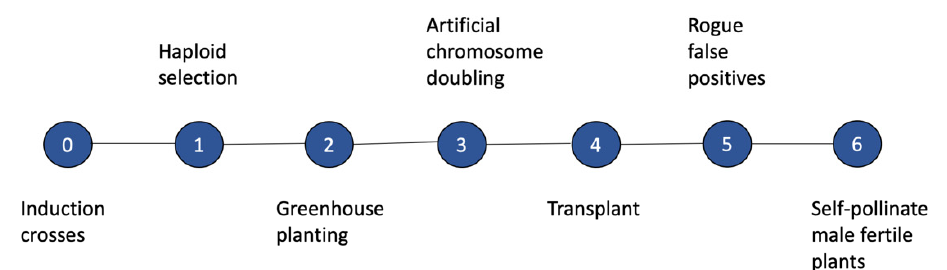
Figure 1. General outline of a pipeline for producing doubled haploids in maize by using a chemical doubling agent for genome